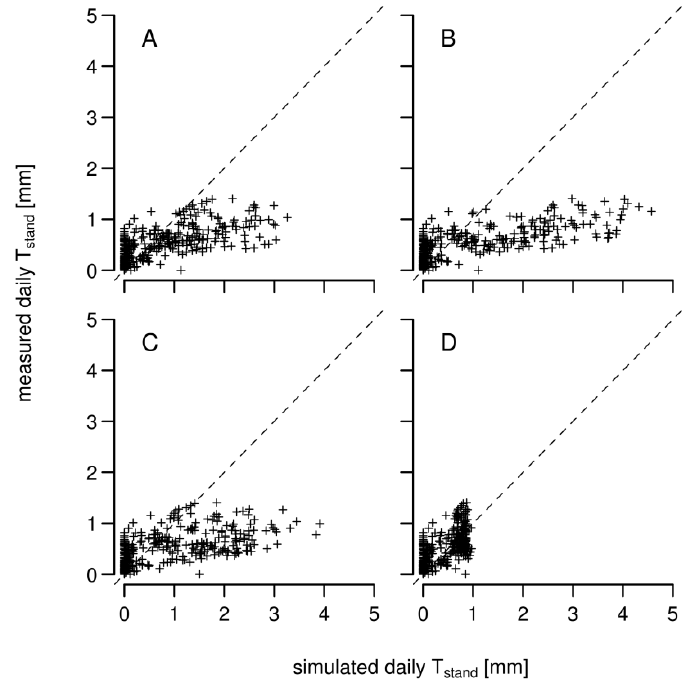
Figure 3. Measured and simulated daily transpiration at P1 site for all both water uptake approaches and root resistances from June 1998 until October 1999 (( A ) = WU1; ( B ) = WU2-low; ( C ) = WU2-medium; and ( D ) =